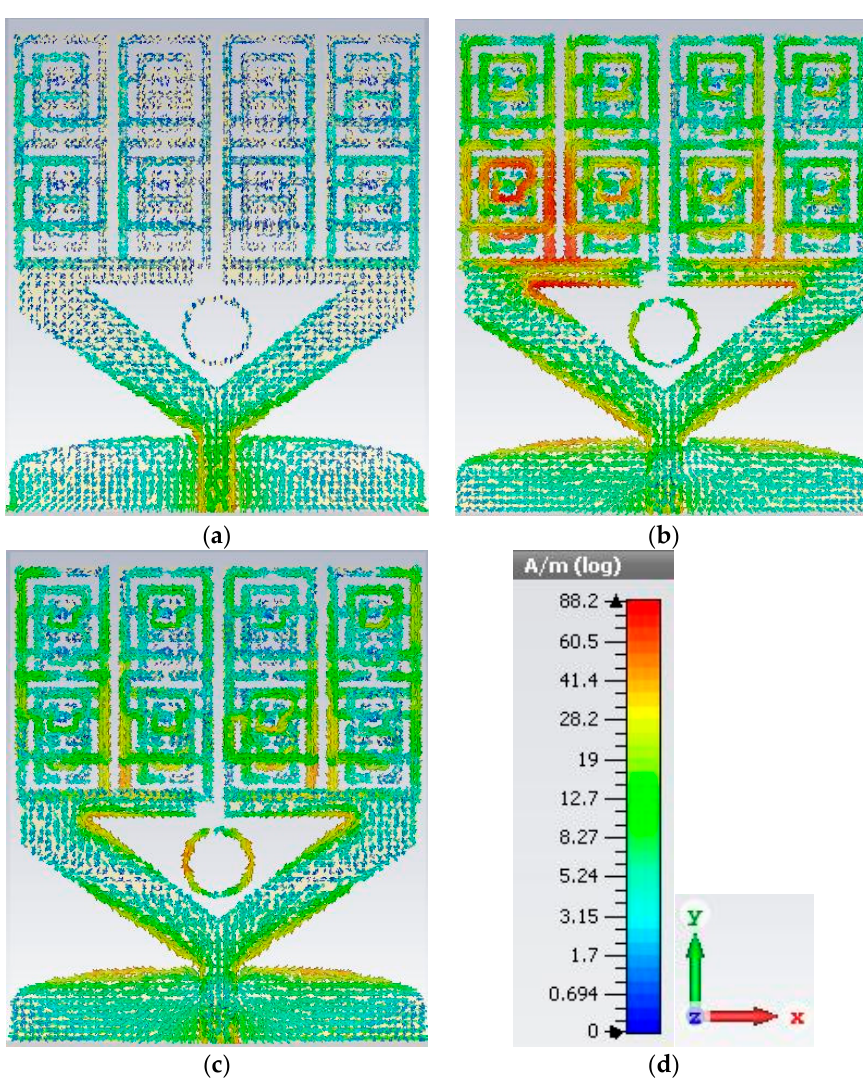
Figure 10. Surface current distribution at ( a ) 4.01 ( b ) 7.63 and ( c ) 8.71 GHz ( d ) Scale.